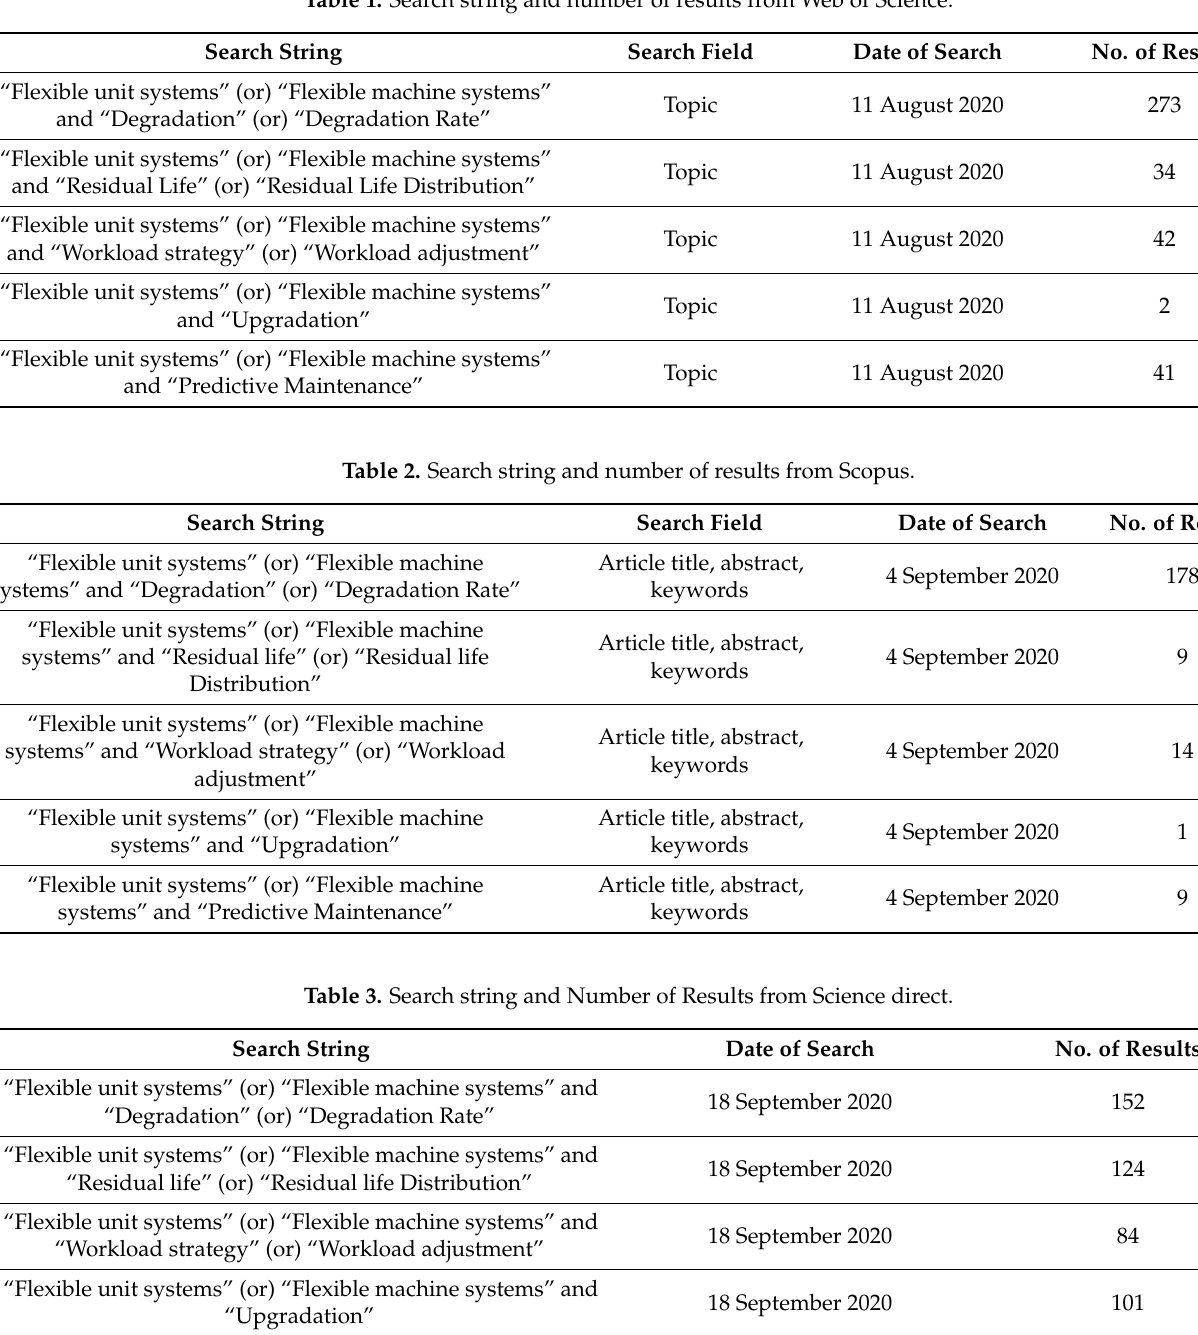
Table 1. Search string and number of results from Web of Science.